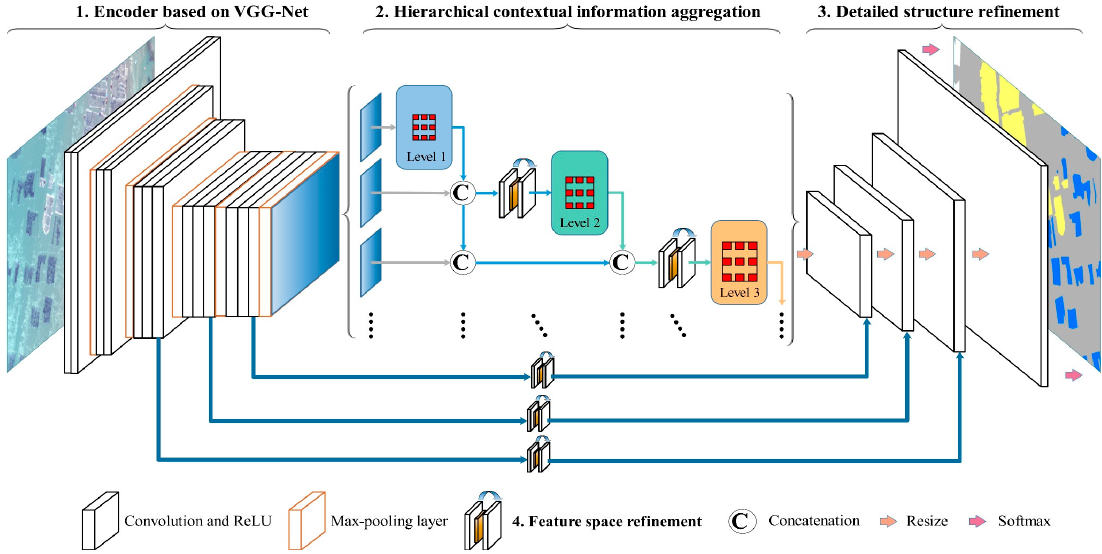
Figure 2. Overview of the proposed hierarchical cascade convolutional neural network (HCNet).